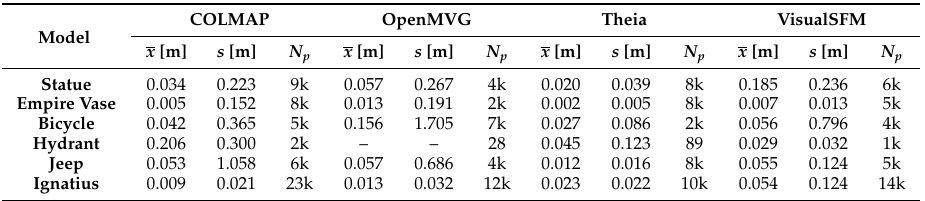
Table 2. SfM cloud evaluation results. x is the average distance of the point cloud from the ground truth and s its standard deviation. N p is the number of reconstructed points.